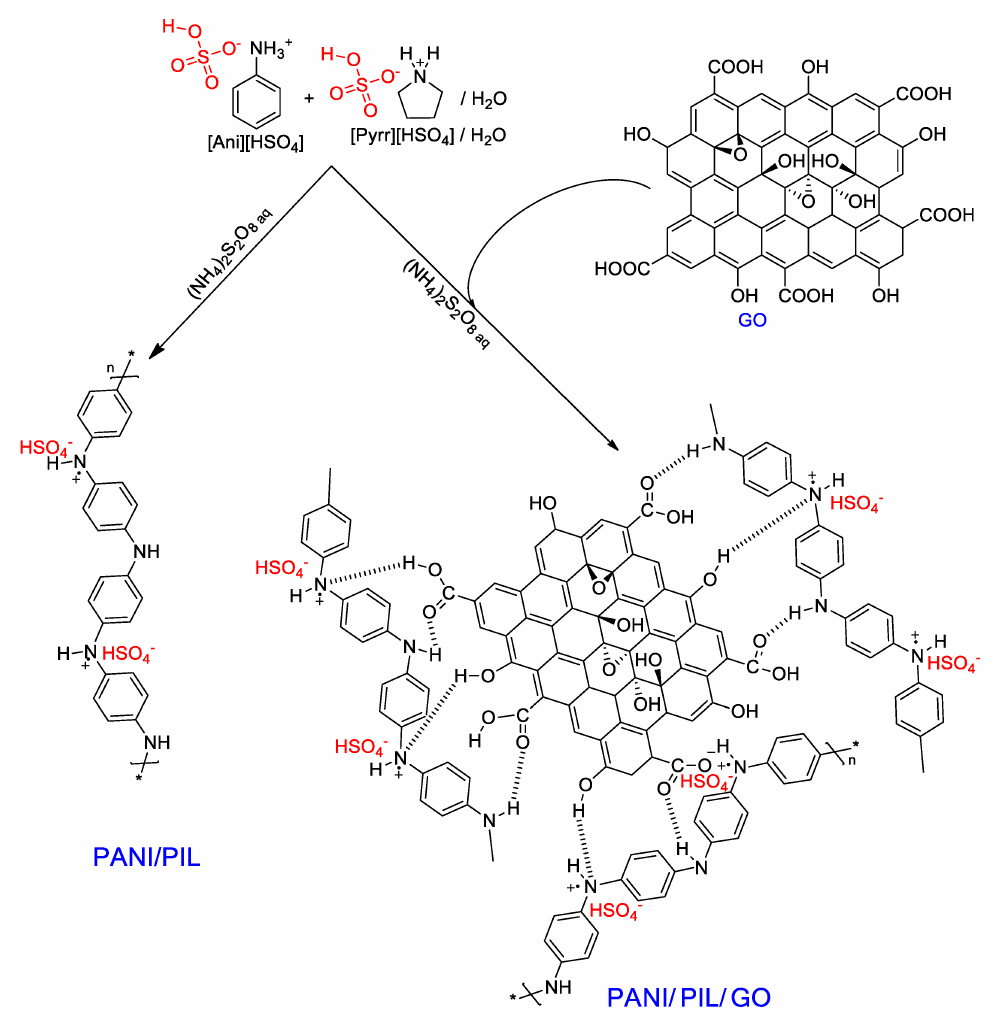
Figure 3. Schematic illustration of the synthesis of PANI/PIL and PANI/PIL/GO